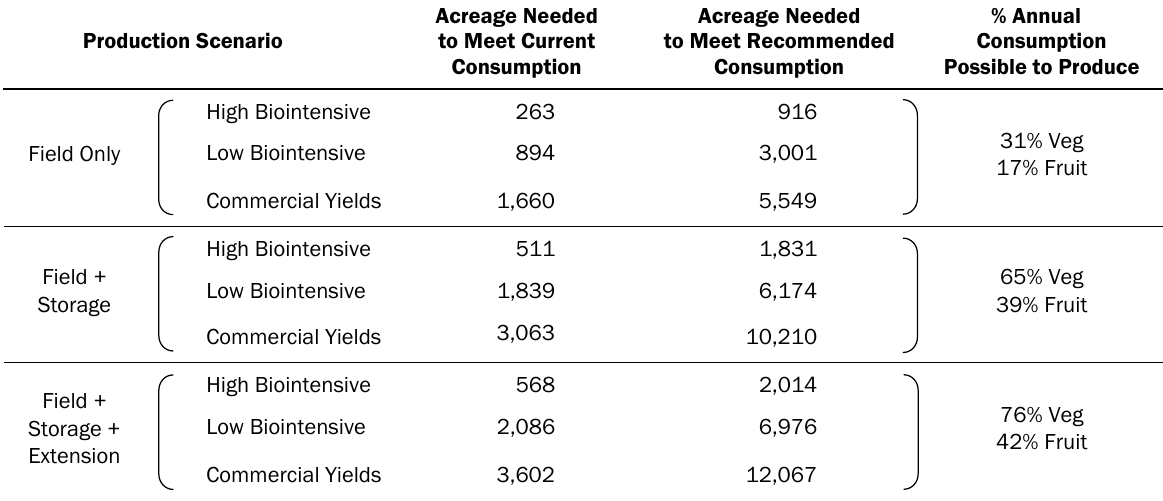
Table 2. Acreage Needed To Supply Current and Recommended Consumption